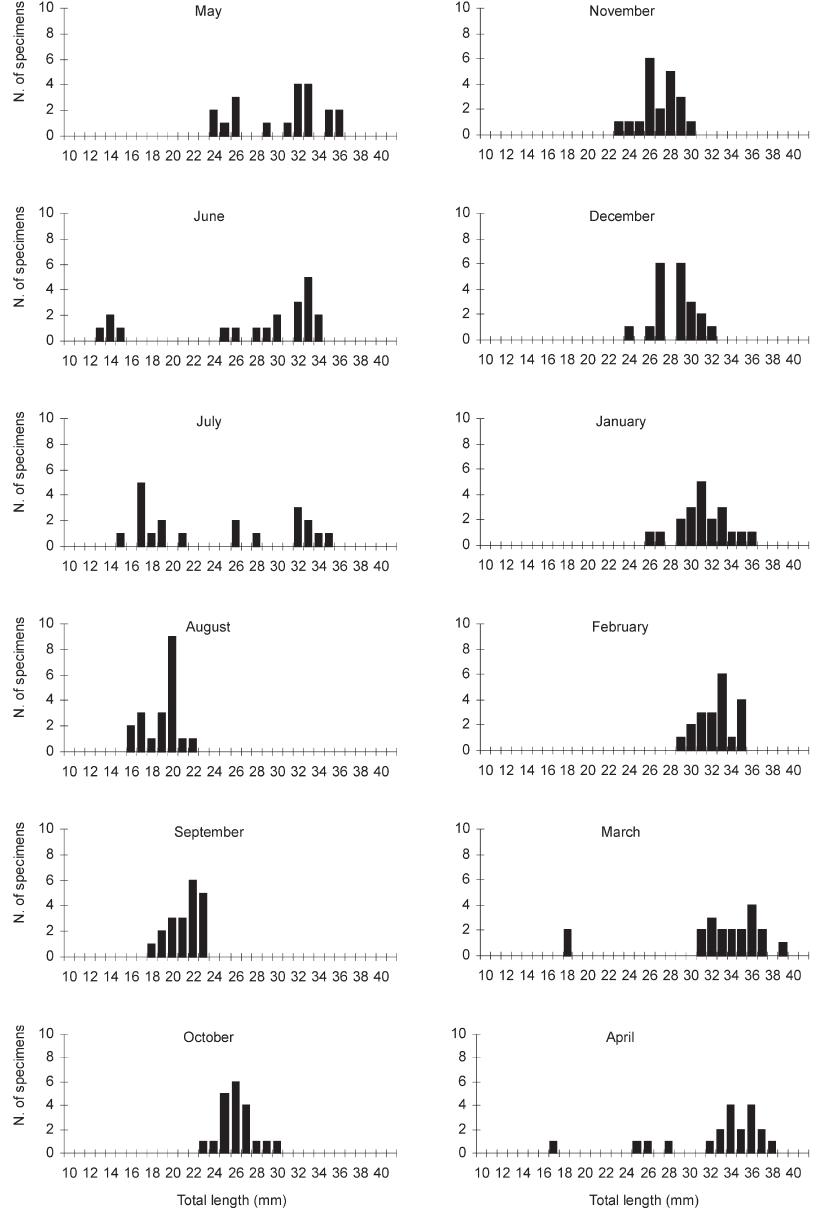
Fig. 5. – Monthly length frequency distributions of Buenia affinis collected in the Kvarner area.